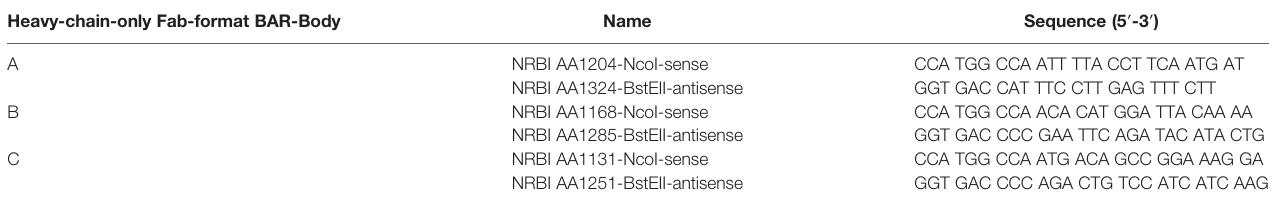
TABLE 1 | Primers used for heavy-chain-only Fab-format neurabin-I BAR-bodies. Heavy-chain-only Fab-format BAR-Body